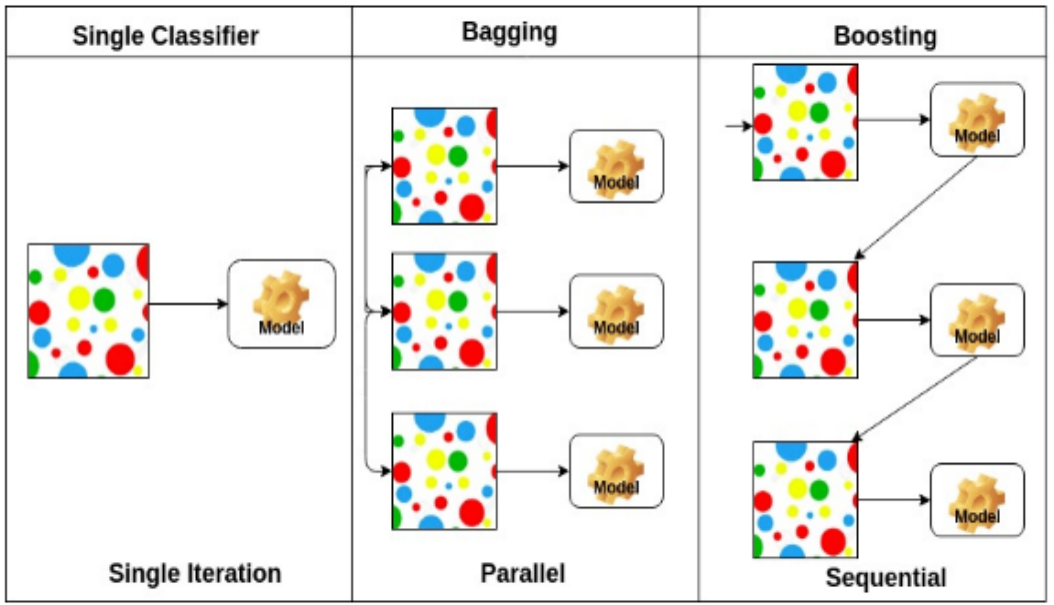
Figure 10. Illustration from Natekin and Knoll (2013) showing how the XGB model ensemble trees sequentially with improving on the previous ensemble as opposed to the bagging method used in RF and single classifiers such as LR and